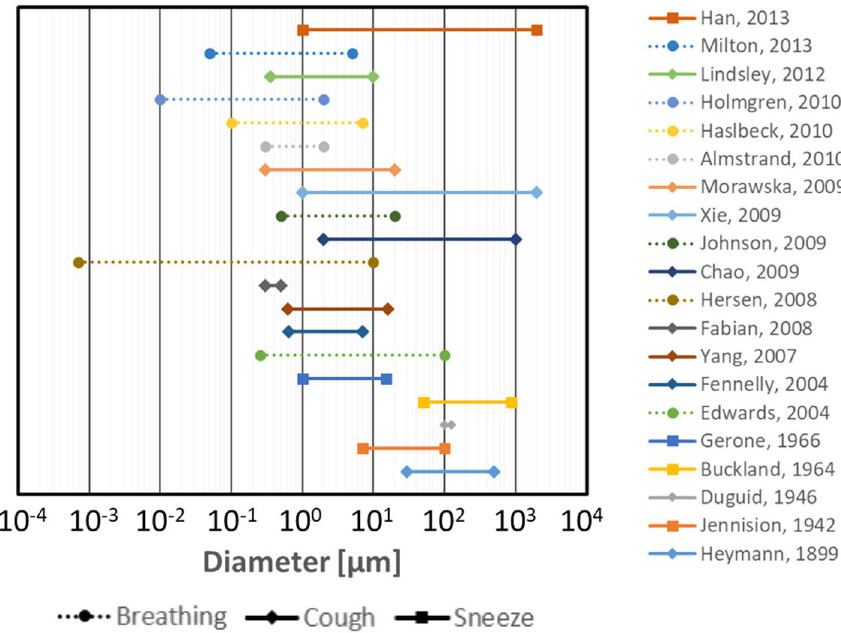
Figure 1. Overview of particle size ranges of respiratory droplets reported in previous studies 8–26